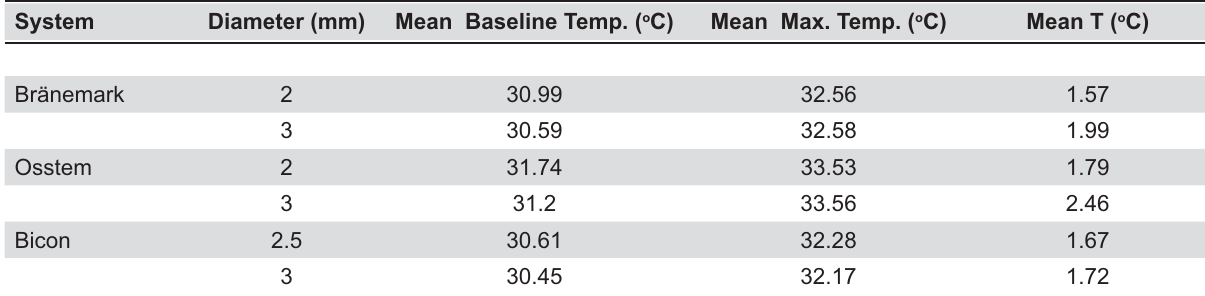
Table 2- Mean baseline temperature, maxiamum temperature, and temperature difference according to implant drill systems and drill *(cid:14)+(cid:24)(cid:2)!(cid:8)